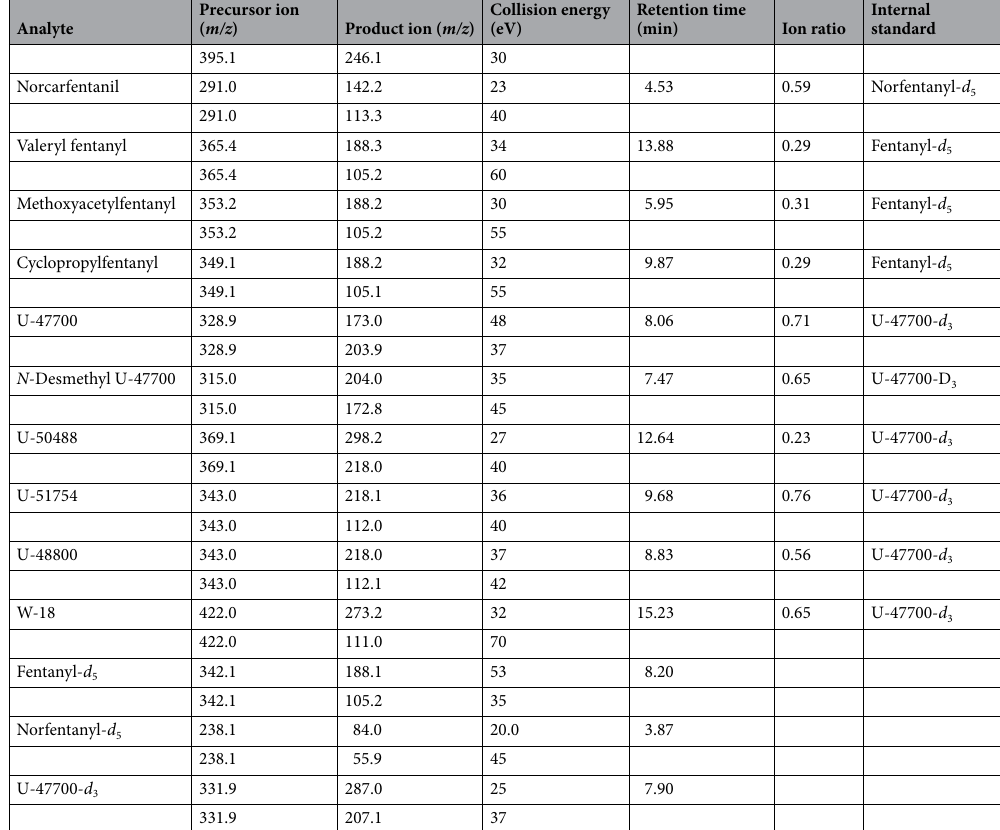
Table 2. MRM transitions and mass spectrometric parameters for analytes and internal